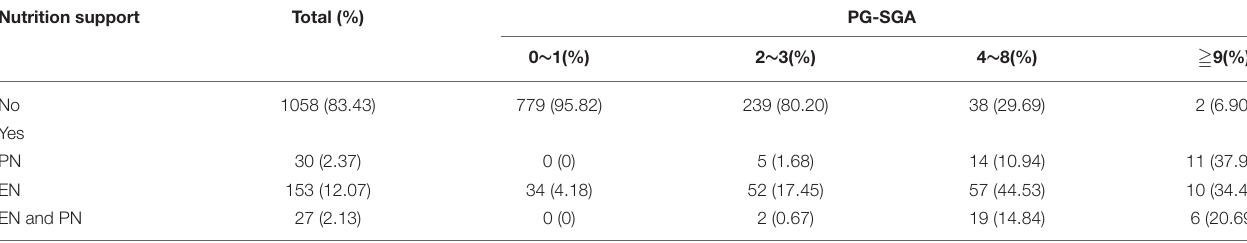
TABLE 2 | Patient-generated subjective global assessment classification and nutritional therapy situation ( N = 1,268). Nutrition support